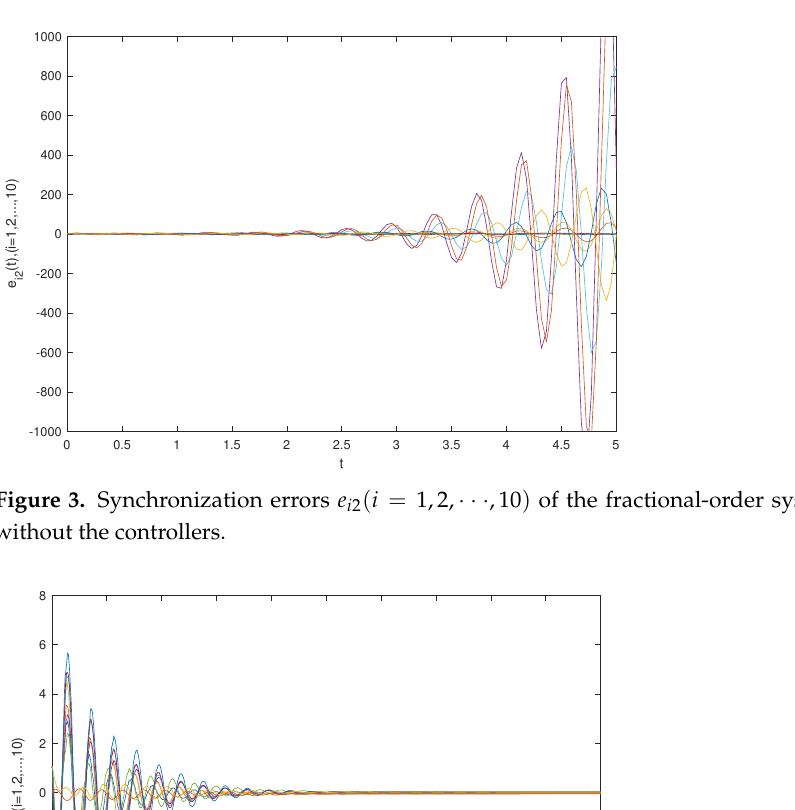
Figure 2. Synchronization errors e i 1 ( i = 1,2, · · · ,10 ) of the fractional-order system (32) and (33) with the controllers.